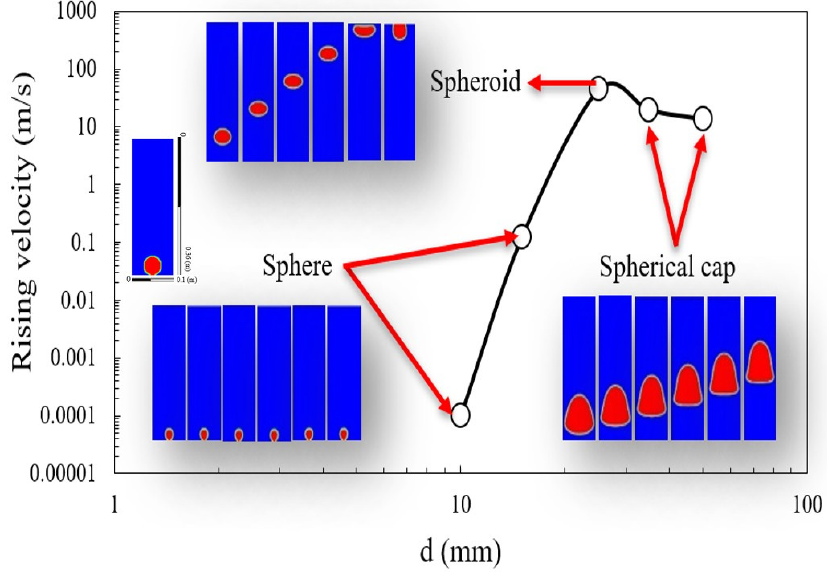
Figure 5. Simulation results of the rising velocity and bubble shape for different bubble radii.